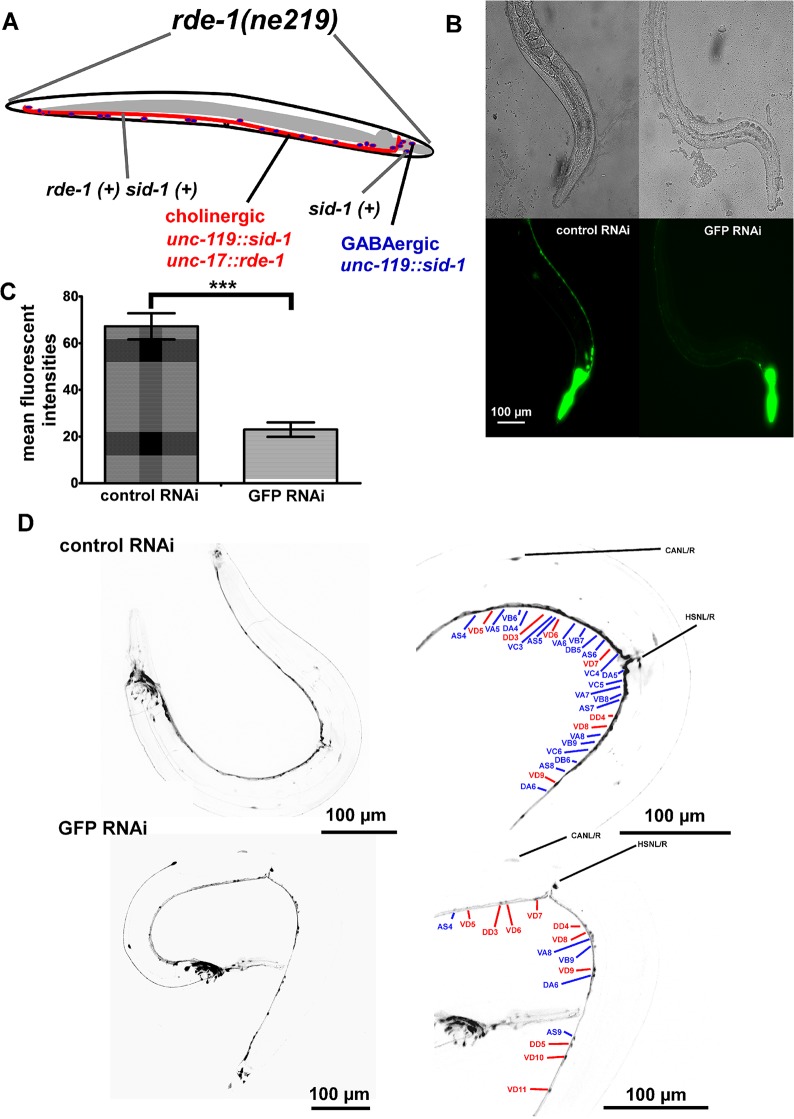
Construction and characterization of a strain with specific RNAi sensitivity in cholinergic motoneurons.
A) The genetic background lacks rde-1, eliminating RNAi in all tissues. RDE-1 is selectively rescued in cholinergic neurons, by expression from the unc-17 promoter. Furthermore, neurons are sensitized to RNAi by overexpression of the SID-1 dsRNA uptake facilitator (using the panneuronal unc-119 promoter). B) Specific knockdown (feeding RNAi) of YFP in cholinergic neurons (using GFP-RNAi bacteria that also target YFP), in an animal expressing YFP panneuronally (punc-119::YFP). Left, mock-RNAi control; right, YFP knockdown, residual YFP fluorescence in ventral nerve cord mainly from GABAergic neurons. C) Group data and statistics of animals as shown in B. Mean ± SEM, background-corrected fluorescence values resulting from the whole nerve cord YFP fluorescence. Compared are animals treated with mock-RNAi vector (L4440) (n = 21) or with L4440::GFP RNAi (n = 15), showing statistically significant reduction of YFP fluorescence (t-test, *** P<0.001). D) Pan-neuronal YFP expression in the RNAi-sensitive strain ZX1800. Animals were treated with bacteria containing the mock-control (L4440) (upper images), or (lower images) the GFP RNAi vector. Reduced YFP expression in the ventral nerve cord can be recognized. In the right images, cholinergic (blue) and GABAergic (red) motoneurons are labeled, in maximum projections of confocal stacks; shown is an enlarged region of the ventral nerve cord surrounding the vulva. Anti-GFP RNAi renders most cholinergic neurons undetectable due to YFP mRNA knock-down.